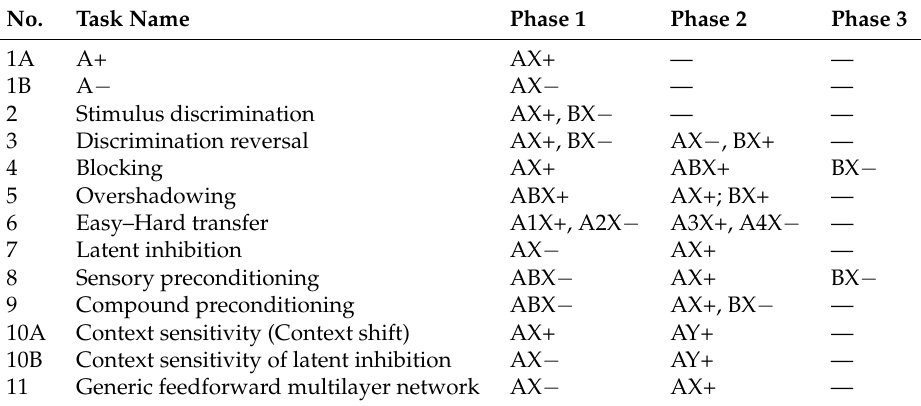
Table 1. All the simulated